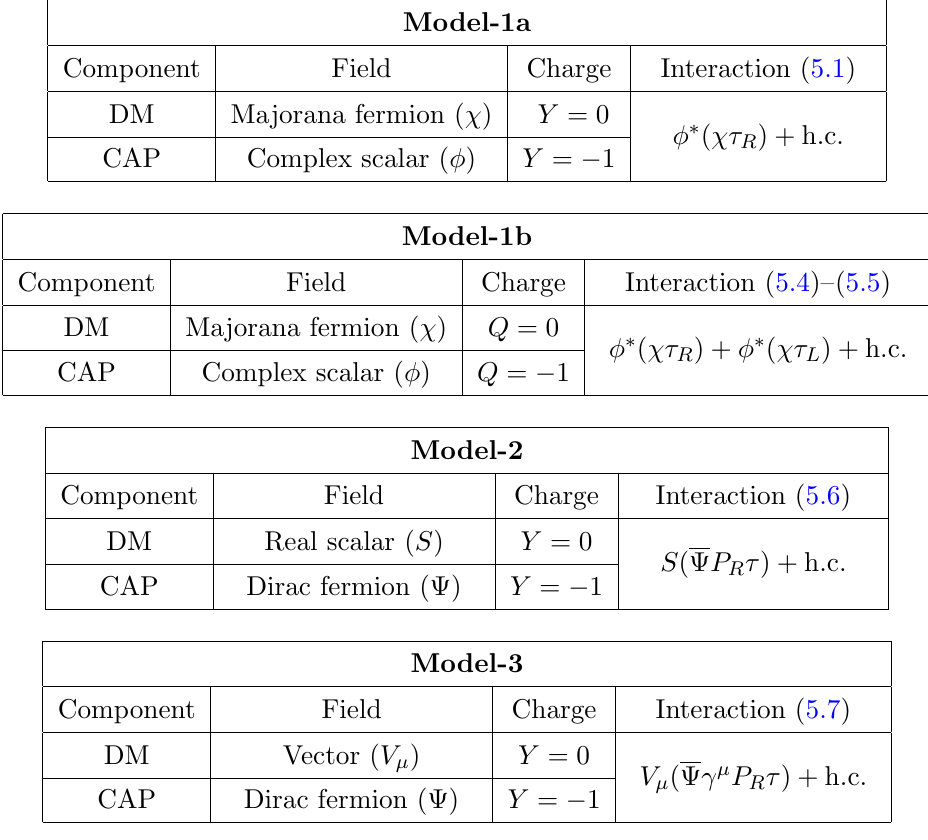
Table 1 . Simpli(cid:12)ed Models of DM with a colourless co-annihilation partner (CAP). are de(cid:12)ned by the three-point interactions between (cid:31) , (cid:17) and the (cid:28) -lepton of the Standard Model